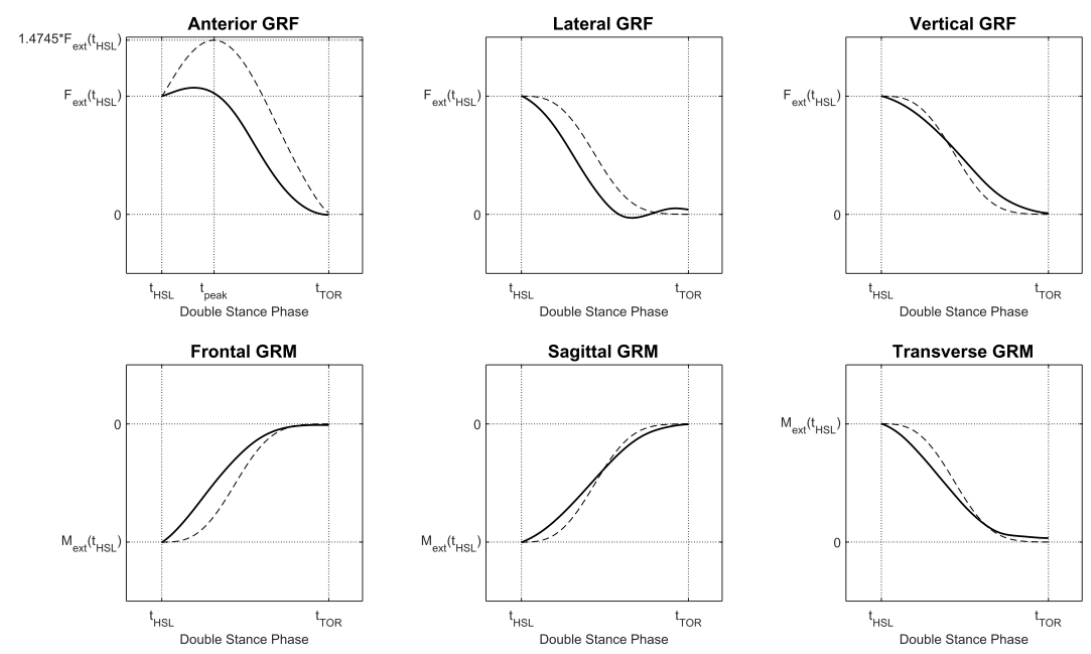
Figure 8. Curves for smooth transition assumption used to distribute external forces and moments among the two feet [45]. Curves were built from empirical data. Dashed lines represents the curves as obtained in a previous study [47].